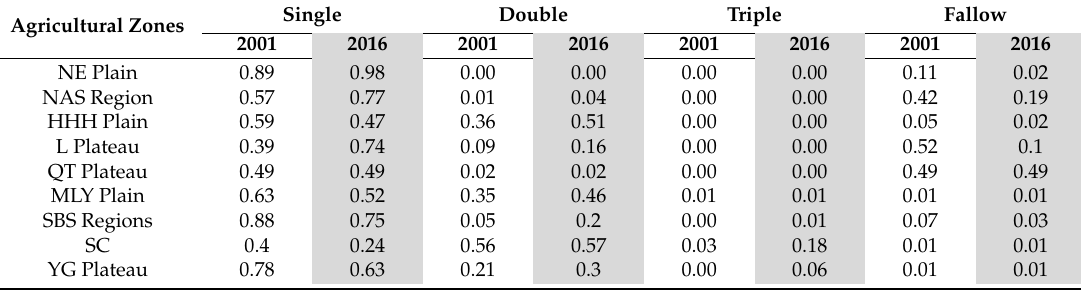
Table 3. Proportions of cropping practices for the arable lands in different agricultural zones in both 2001 and 2016.